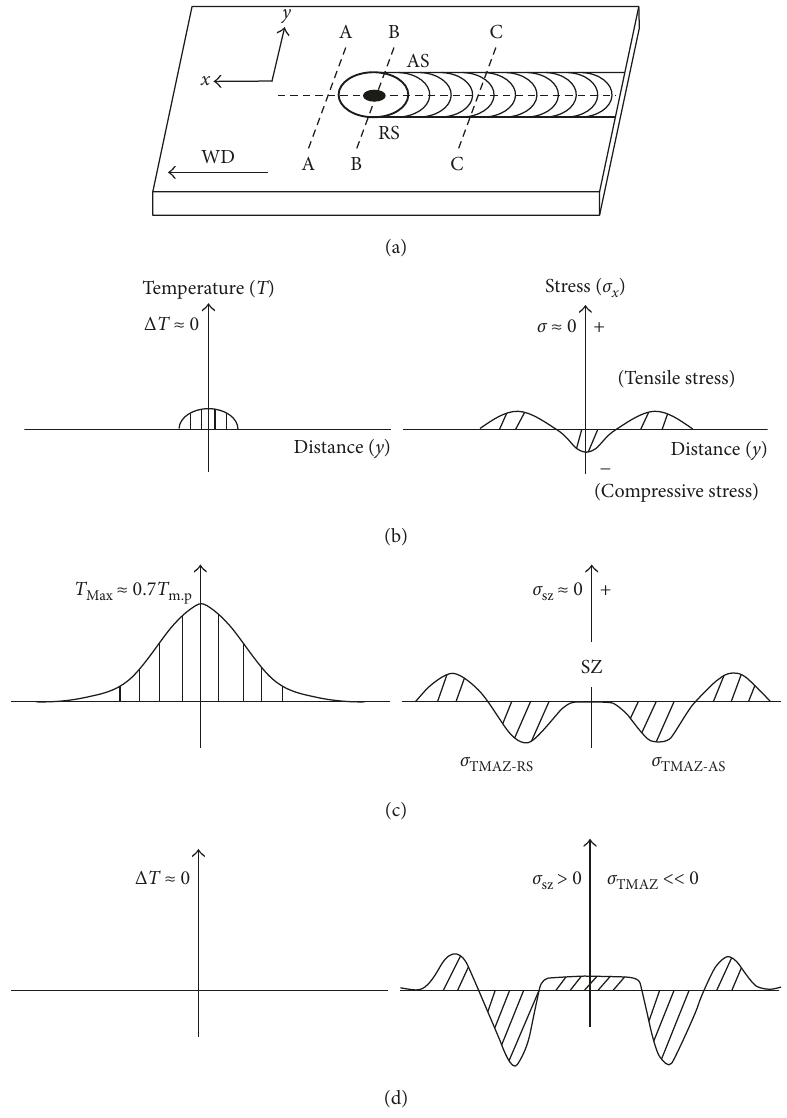
Figure 11: Temperature distribution and residual stress formation behavior during friction stir welding. (a) A-A: just before welding, (b) B- B: during welding, and (c) C-C: after